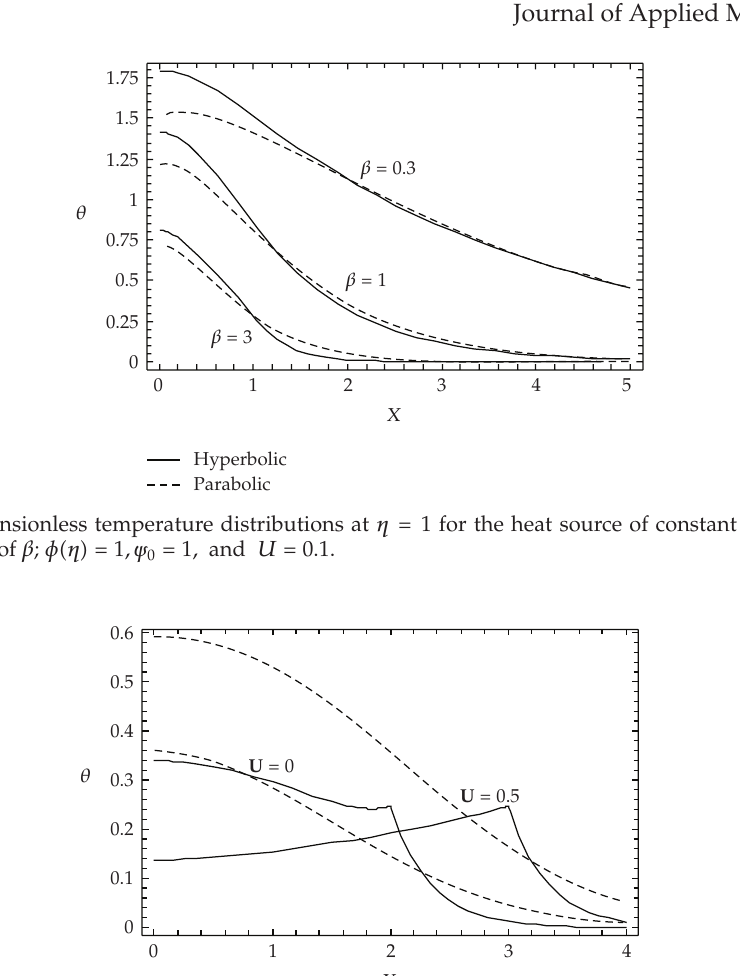
(cid:5) 1 ,β (cid:5) 0